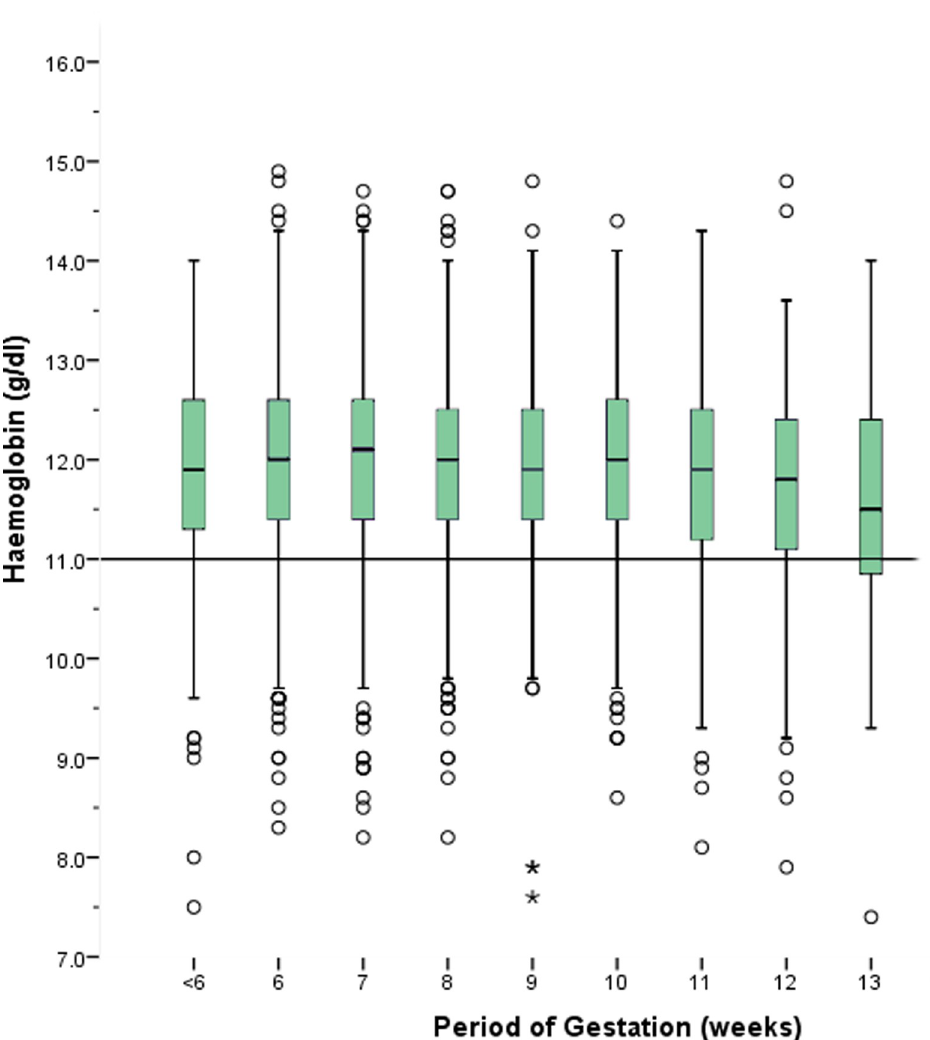
Fig 1. Haemoglobin level of first-trimester pregnant women by the period of gestation.